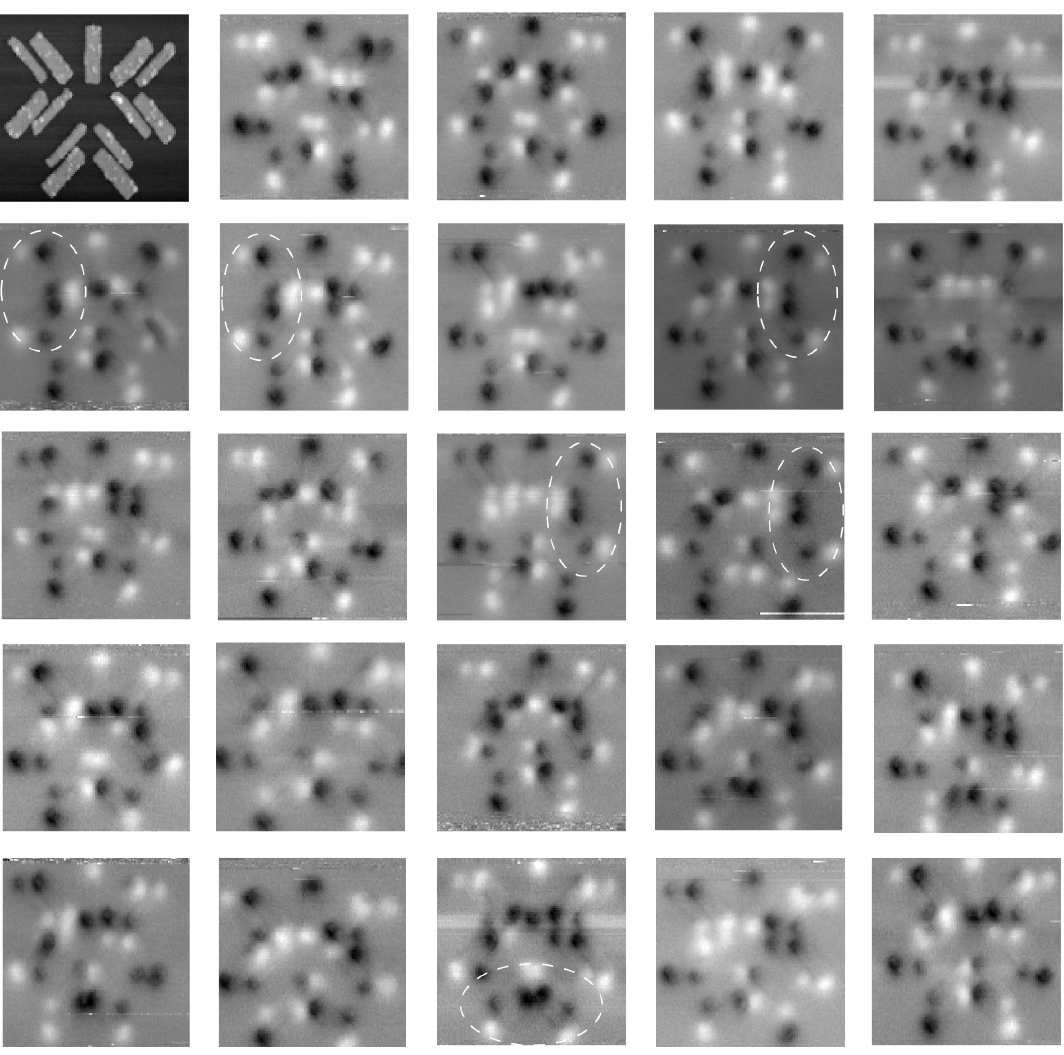
Figure 18: Magnetic force microscopy (MFM) data on a 24 T-junction set-ups us- ing three Dragonfly’s. The magnet dimensions are the same as in Fig. 1 but the distance between them differs. Top left: Atomic force microscopy (AFM) of one T- junction setup with three dragonfly magnet configurations. Magnetic film height 20 nm. Dashed ovals point out magnetizations favorable for generating MZM. The mag- netic history was a magnetizing field from 100 mT to -16 mT to 0 mT applied at 45 degree direction, then 100 mT to -16 mT to 0 mT at 135